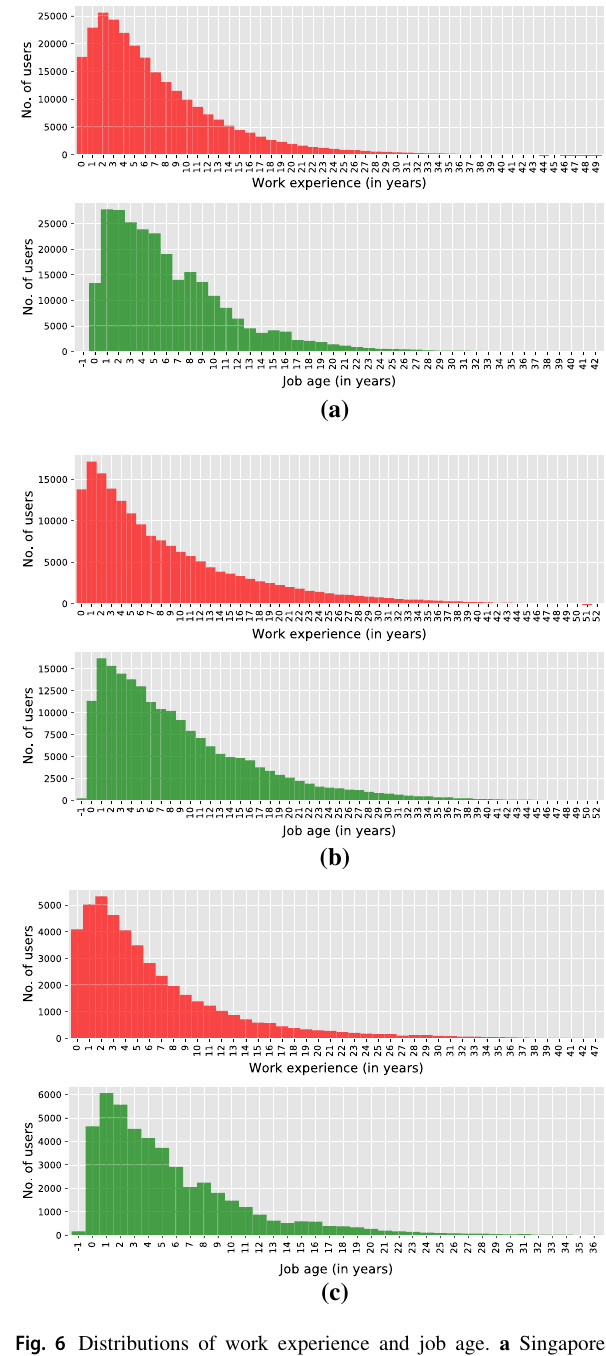
Fig. 6 Distributions of work experience and job age. a Singapore. b Switzerland. c Hong Kong